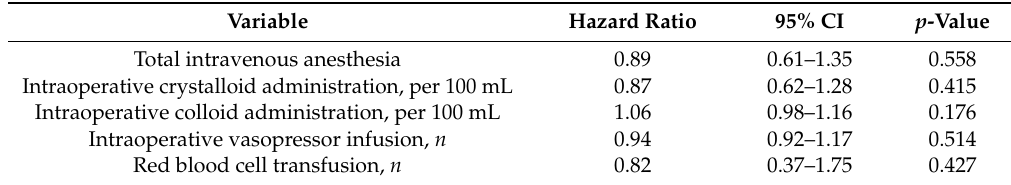
Table 3. Multivariable linear regression analysis of functional change ratio after radical nephrectomy.